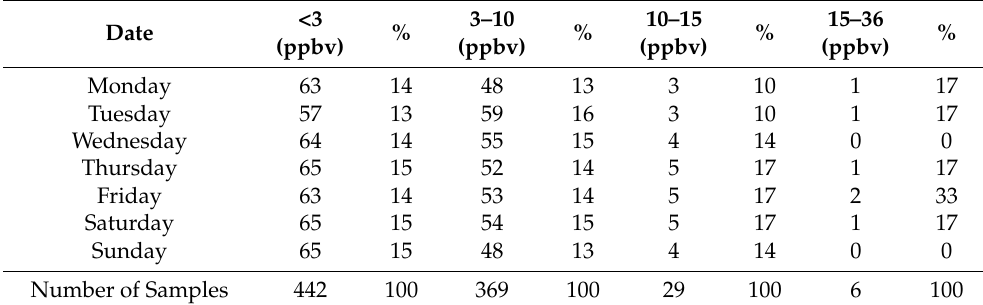
Table 2. Proportion of formaldehyde concentration ranges separated by day of week and concen- tration range. The bottom row in columns 2, 4, 6, and 8 are the sum of the number of days in the analyzed data set that HCHO ranged between <3 ppbv, 3–10 ppbv, 10–15 ppbv and 15–36 ppbv. The bottom row in columns 3,5,7 and 9 are the sum of the percentages of time that the concentration ranges occurred between Monday and Sunday.